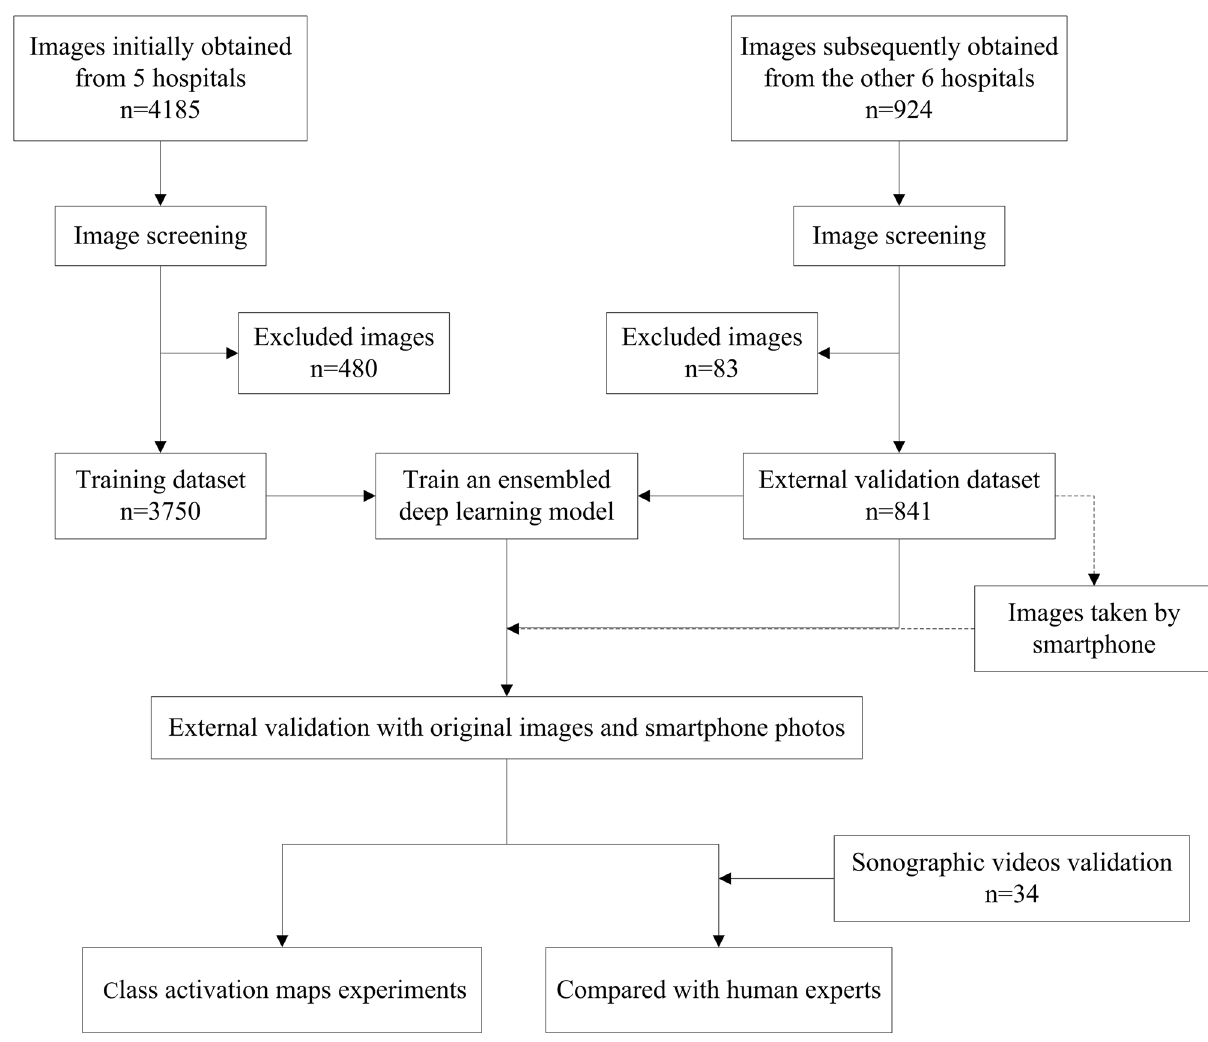
Fig. 7 Flow chart of the study. For each infant, sonographic gallbladder images were acquired either prospectively or retrospectively. The prospective image acquisition needed to satisfy the following criteria: (1) images were acquired after the patient fasted for at least 2 h; (2) gallbladder was detected by high-frequency transducers (>7 MHz); (3) a complete outline of the gallbladder long axis was included; (4) there was no mark or caliper within the image; (5) the depth of the image was <5 cm; (6) the image resolution was large enough (often larger than 300-by-300 pixels); (7) at least 2 independent gallbladder images were obtained from each patient. When images were acquired retrospectively, at least the criteria (1), (2), (3), (4), and (6) need to be satis fi